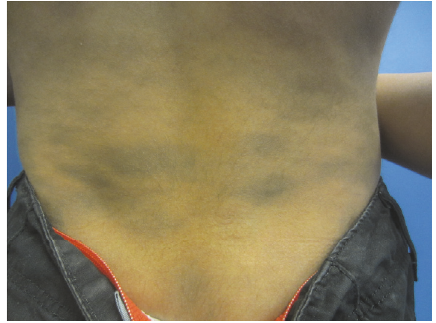
Figure 3: Well-demarcated oval blue-gray macules and patches symmetrically distributed over the lower back.